Question: What does this figure show? Answer in one sentence.
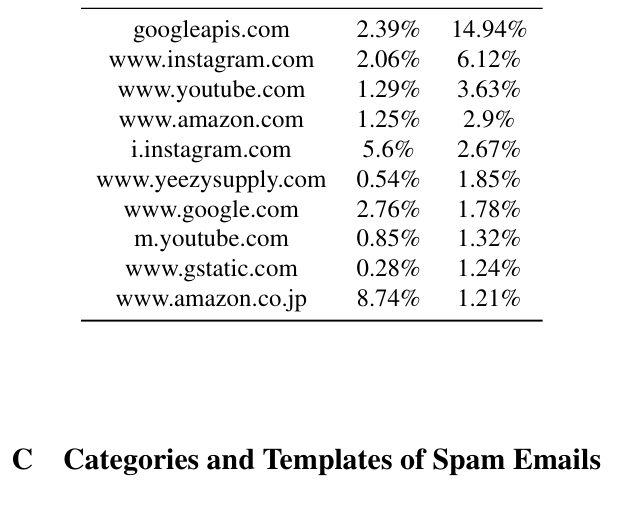
Answer: presents two templates of spam emails observed in RESIP traffic, while the distribution of spam Emails across their categories are listed in Table 11.